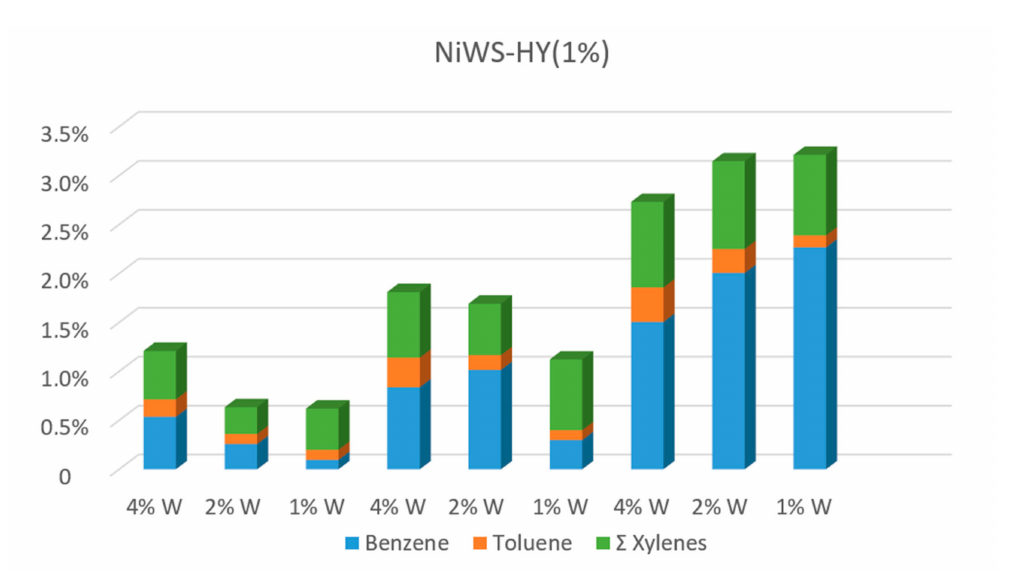
Figure 2. BTX (benzene, toluene, xylene) components selectivity in hydrocracking reaction of naphthalene solution with NiWS-HY(1%) catalysts at standard conditions P = 5 MPa, t = 5 h, and W:Ni ratio =